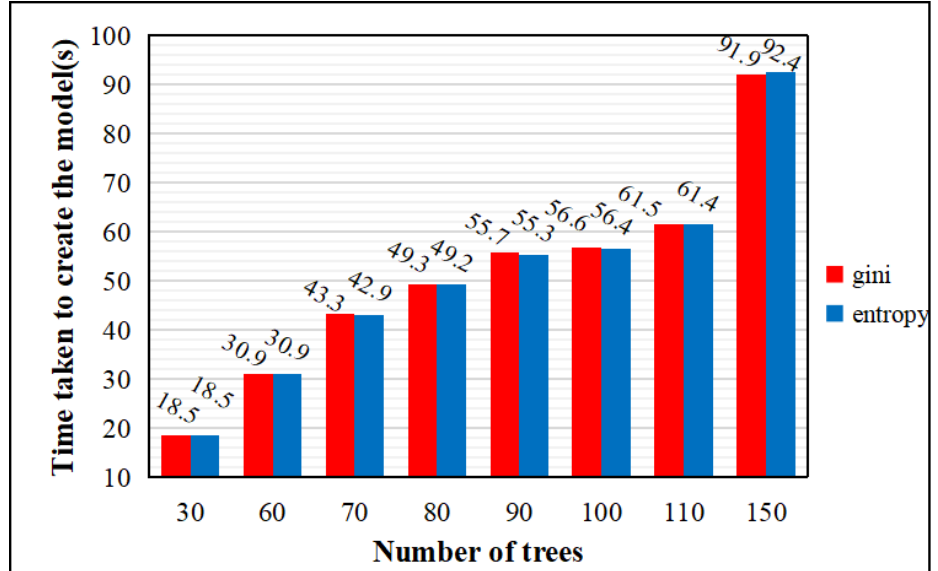
Figure 7. Variation of model creation time with tree growth for entropy and gini index